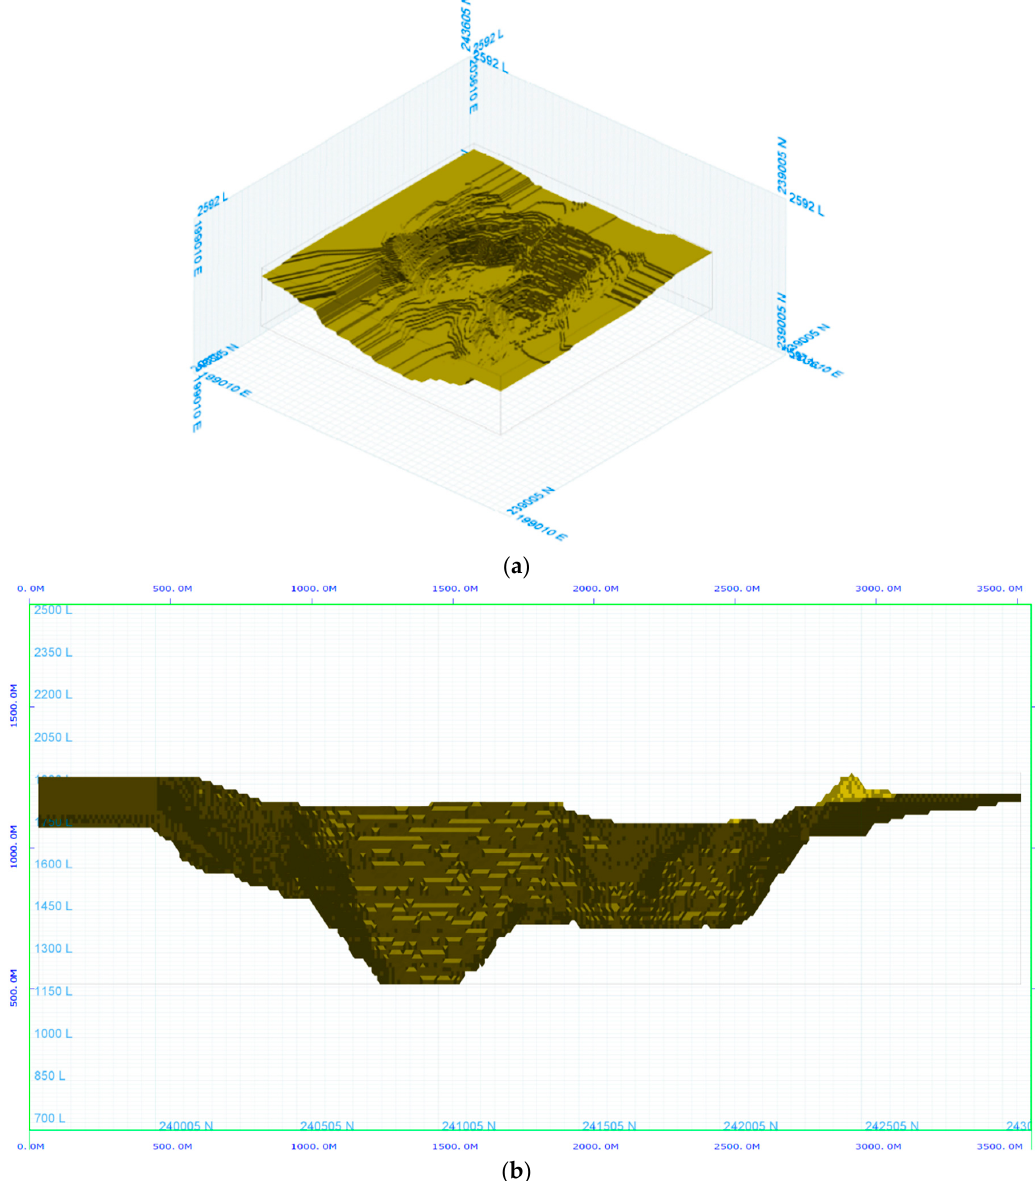
Figure 6. Topography’s deposit. ( a ) Isometric view and ( b ) S-N section, E view.